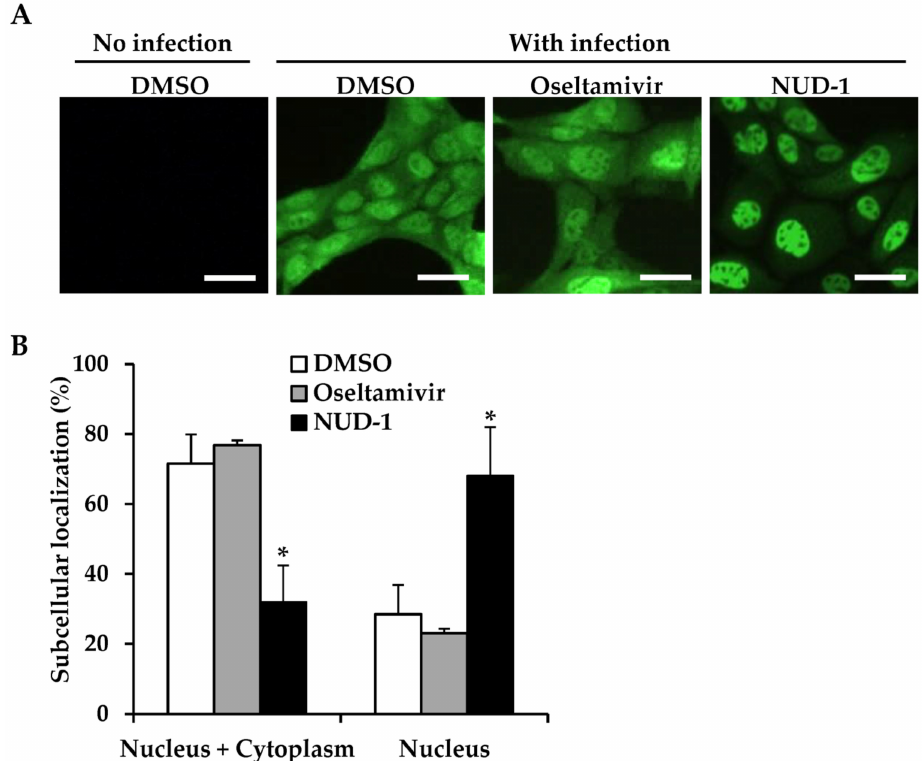
Figure 4. Subcellular localization of nucleoprotein (NP). Madin–Darby canine kidney cells were infected with the A / WSN / 33 virus (multiplicity of infection = 5) in the presence of DMSO, oseltamivir (16 µ M), or NUD-1 (16 µ M) and incubated for 9 h. ( A ) The cells were fixed and stained with anti-NP antibody followed by Alexa Fluor 488-conjugated secondary antibody to determine the subcellular localization of NP. One representative result from three independent experiments is shown. Scale bar, 25 µ m. ( B ) The percentage of cells exhibiting both nuclear and cytoplasmic localization and only nuclear localization of NP was calculated by counting two microscopy fields per experiment. The presented data are the mean and standard deviation of three independent experiments with statistical analysis in comparison to DMSO control. The asterisk indicates a p value of less than